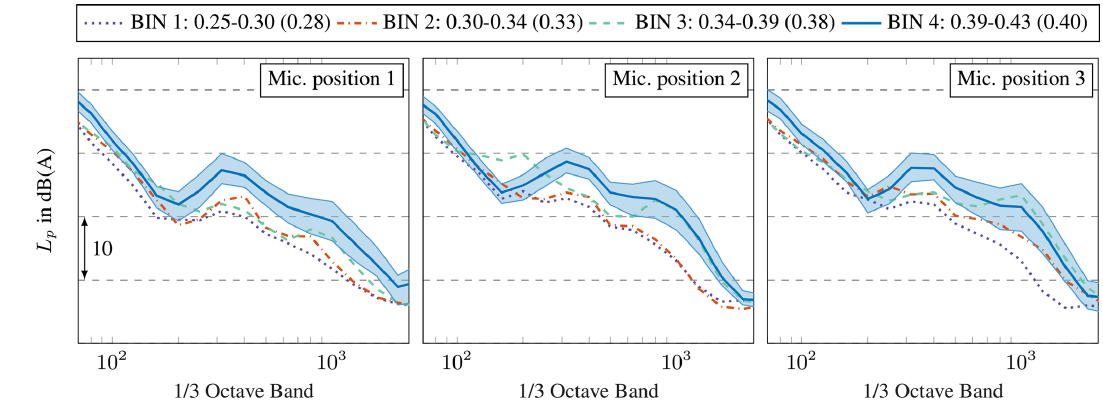
Figure 6. Measured background noise per one-third octave band for different wind speed bins at three microphone positions. The wind speeds were recorded at a height of 100m and are divided into bins of 1ms − 1 . The bins are normalised to the cut-off wind speed of the turbine. The average normalised wind speed during the background noise measurements is given in parentheses. The measured sound levels in the bins are energetic averages over the corresponding measurement period. Representative of all bins, the standard deviation of the measurements is given for bin 4, which includes the data at the highest wind speed during the background measurements.